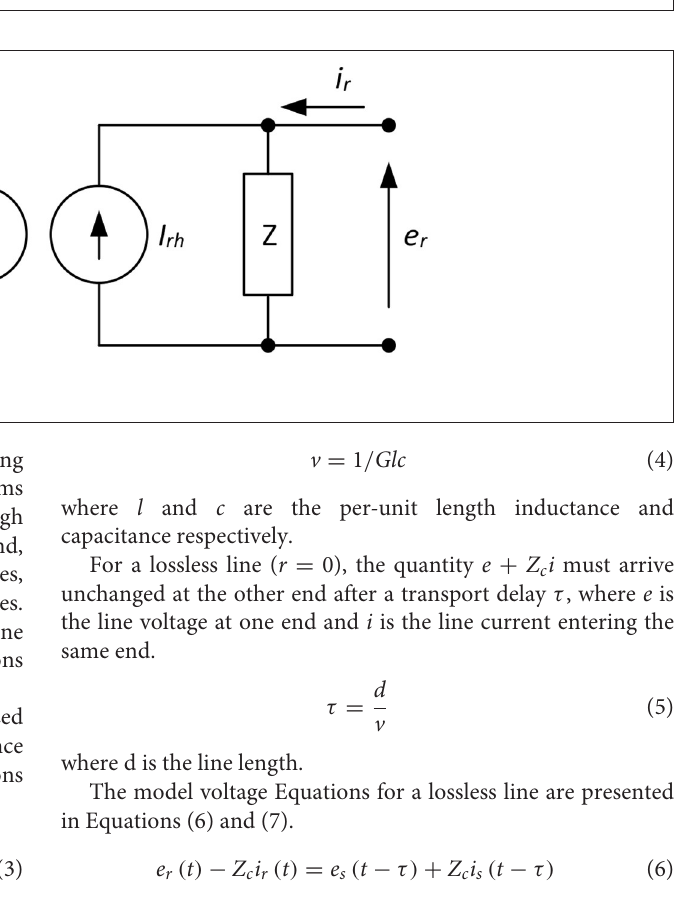
FIGURE 1 | Block diagram of the proposed system: (A) without bypass of proposed meter; (B) with bypass of proposed meter.